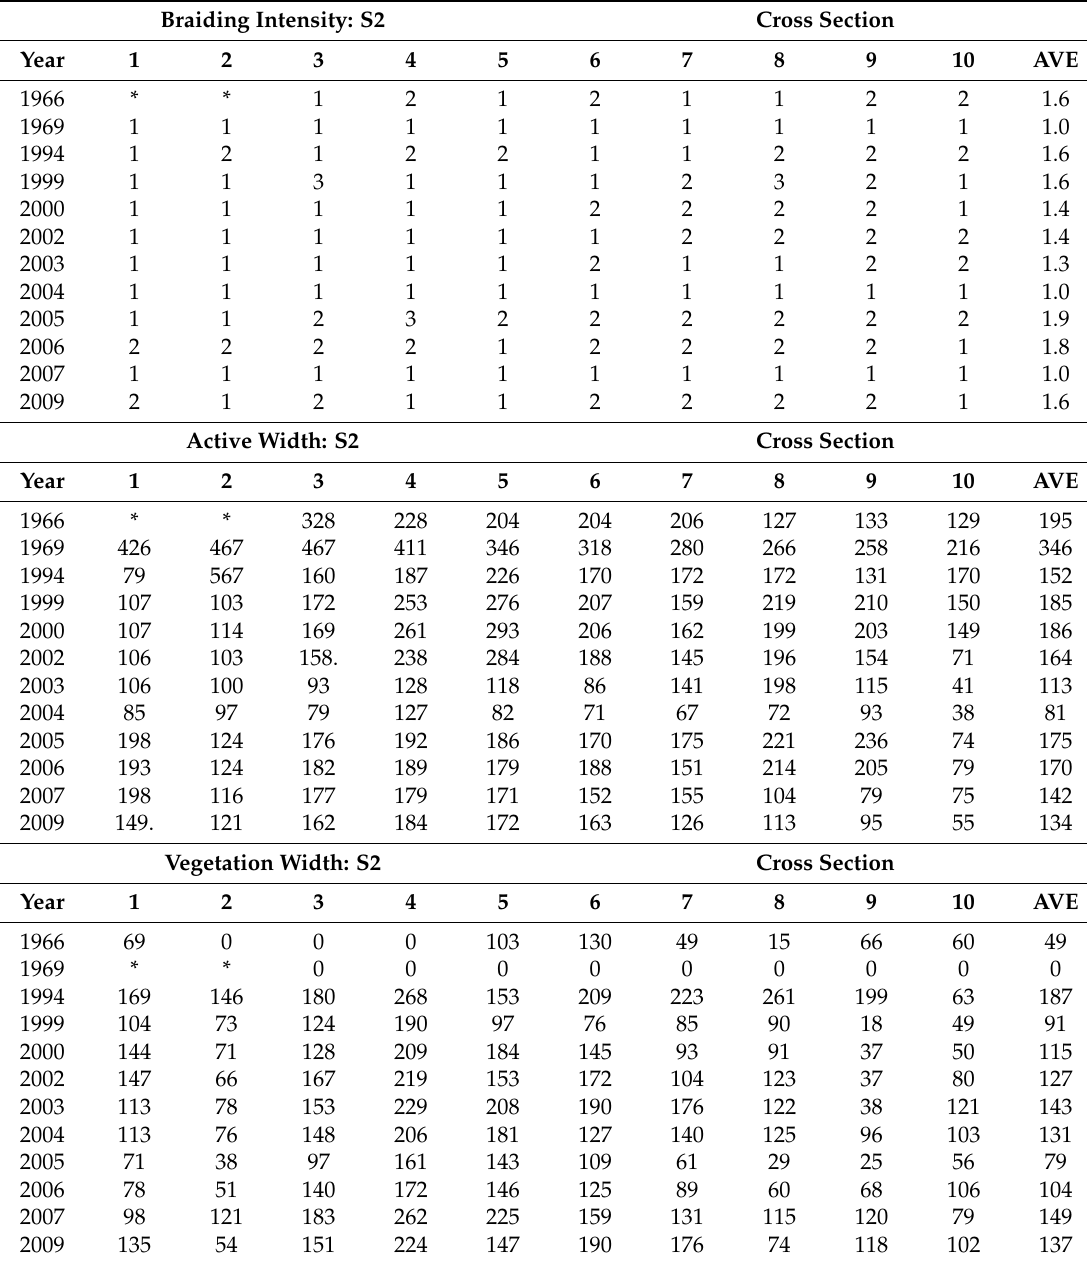
Table A4. Summary of measurements made from cross sections for. aerial photos from site S2 of intensity of braiding (mean number of channels), active width (m) and vegetation width (m). Locations of cross sections are shown on Figure